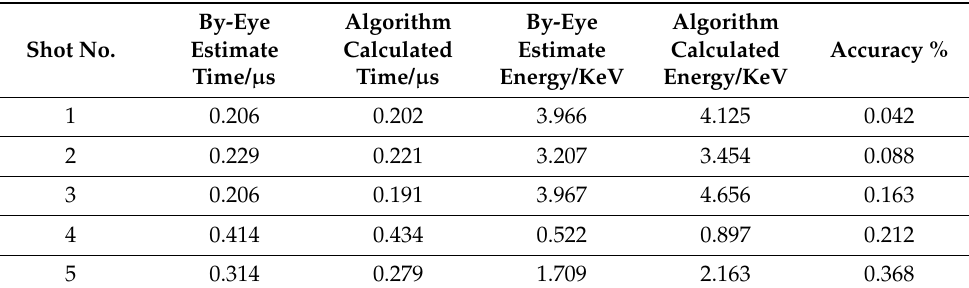
Table 1. Gradient-method calculated predictions of shortest time-of-arrival and corresponding max. proton energies for a number of the training datasets, along with the corresponding equivalent energies. Shots arranged in order of decreasing S/N ratio. The accuracy was calculated from the deviation between estimate and algorithm answers as a percentage of full dataset size.